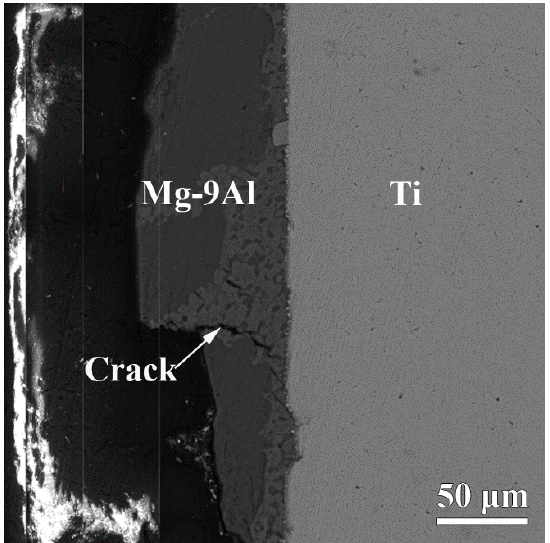
Figure 10. BSE cross-sectional view of the Mg-9Al/Ti metallurgical bonding at 700 °C for 60 min.